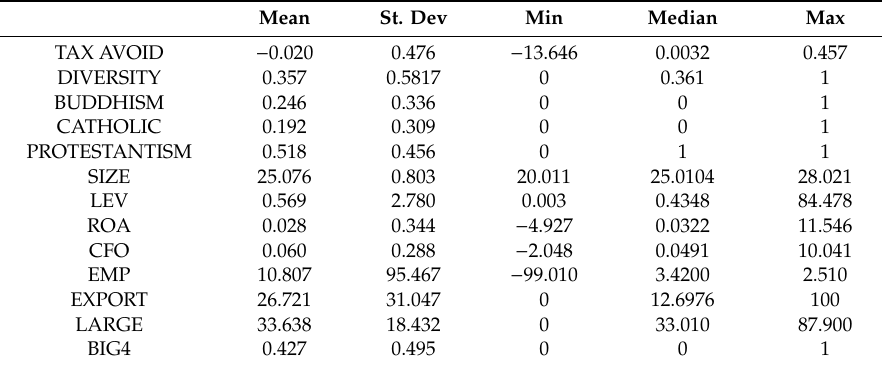
Table 1. Descriptive statistics ( n =